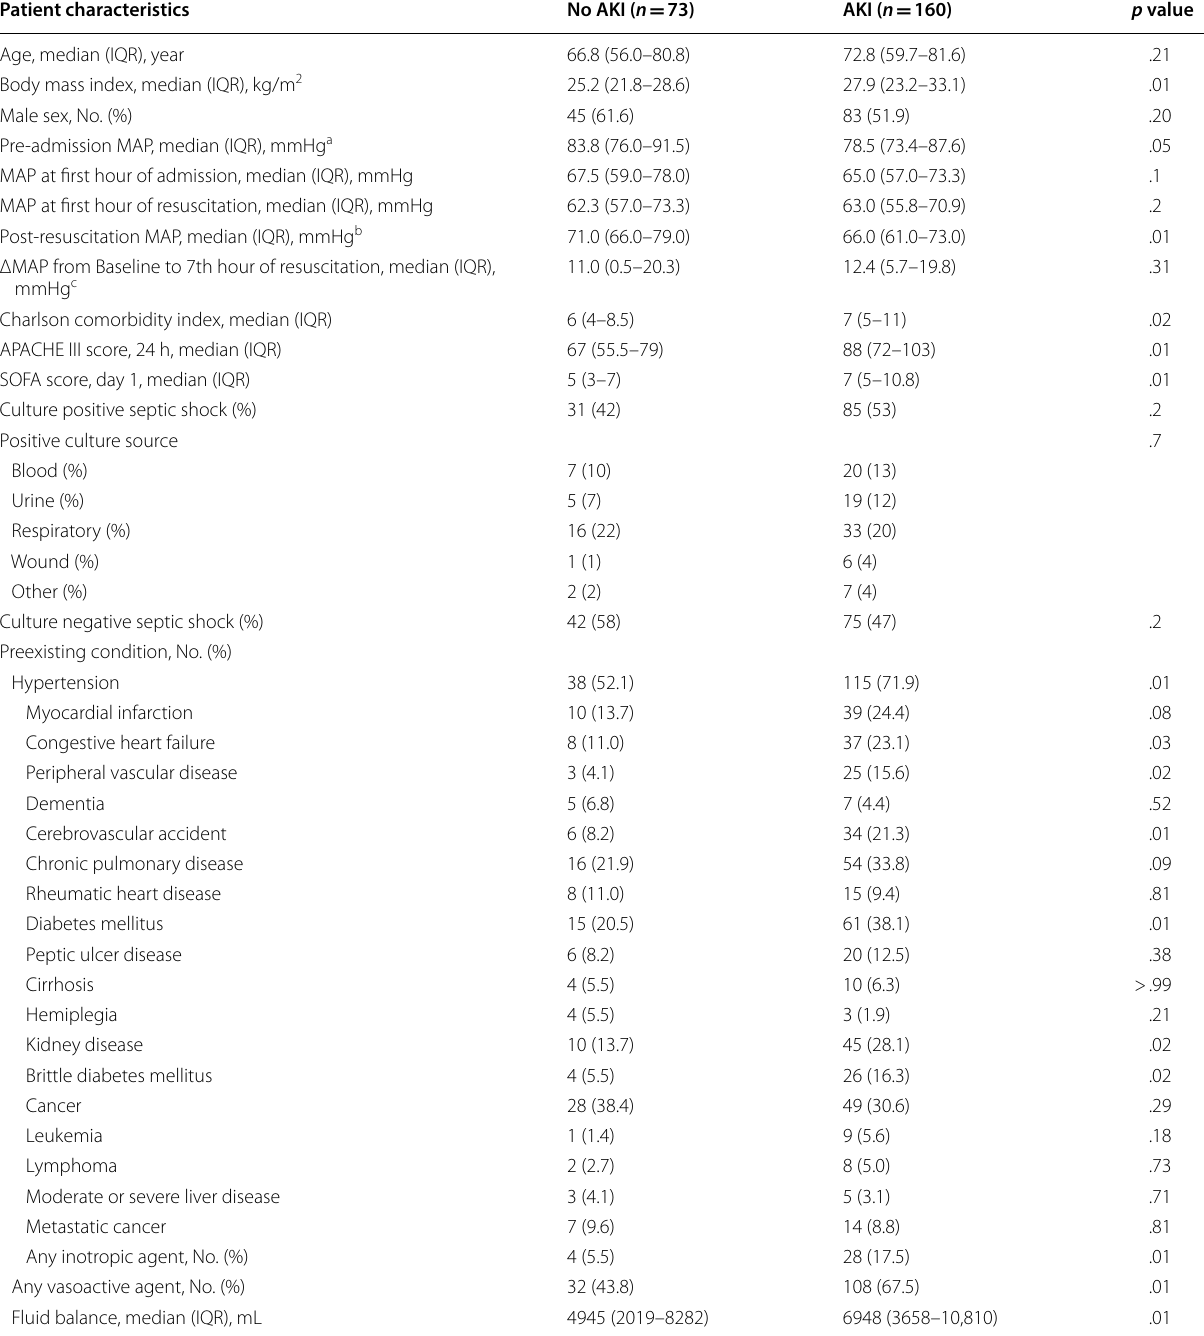
Table 1 Patient characteristics, stratified by acute kidney injury status ( N